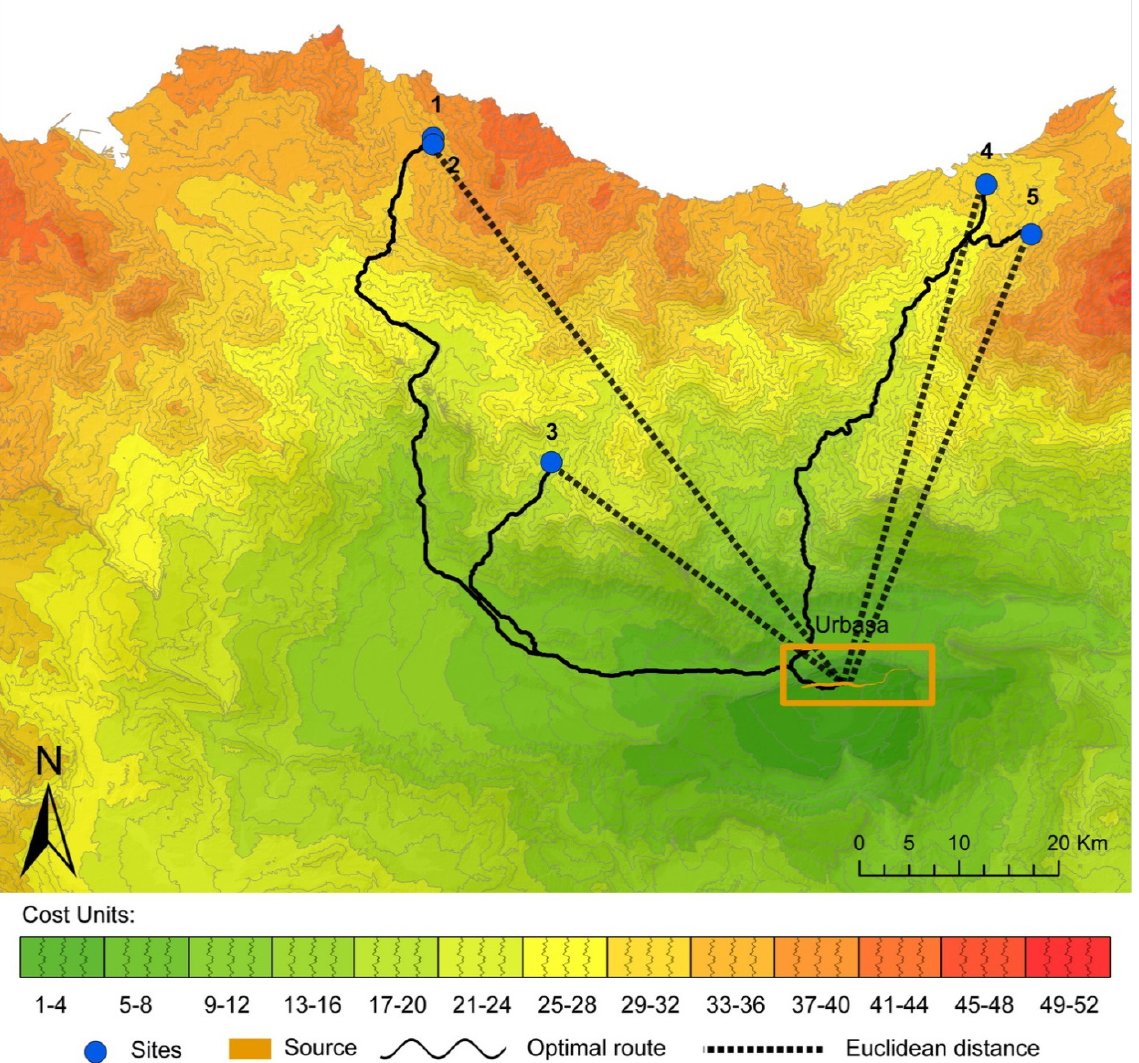
Figure 7. Map of the expansion of the Urbasa flint representing the three types of measurement evaluated in this paper: Euclidean distance, the distance through the optimal route and cost. Legend: 1. Antoliñako Koba, 2. Santimamiñe, 3. Labeko Koba, 4. Ametzagaina and 5. Aitzbitarte